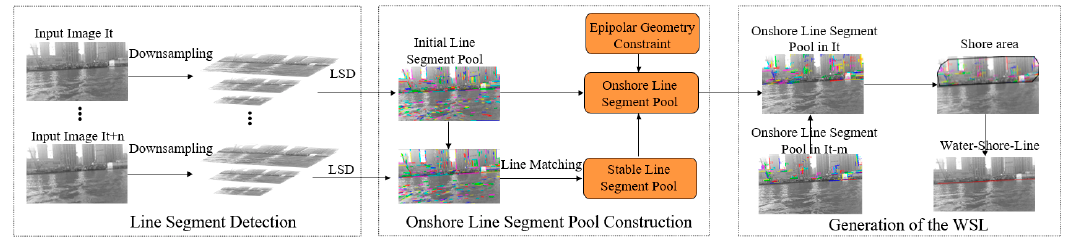
Figure 1. The framework of the water-shore-line (WSL) detection method for unmanned surface vehicle (USV) in inland river scene.